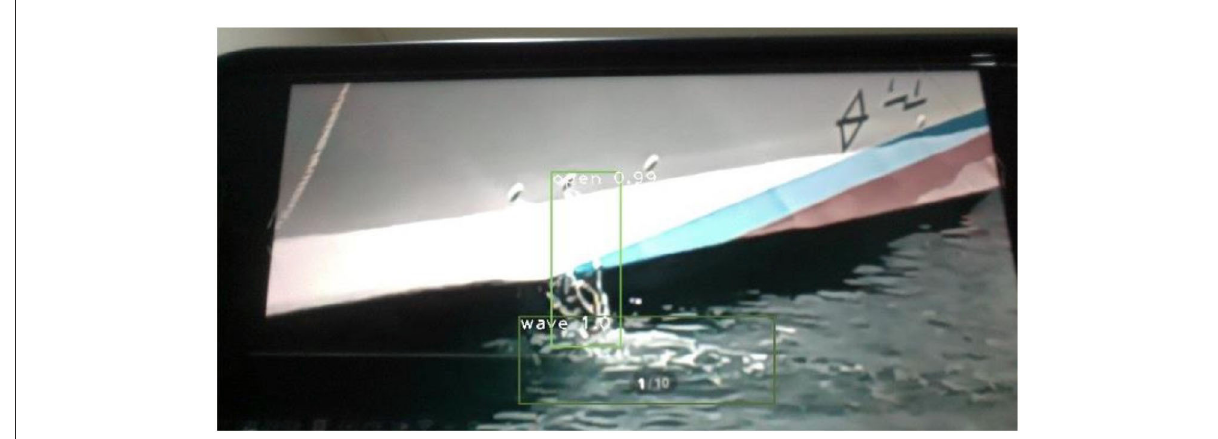
FIGURE3 Monitoring if any sailboat violates the rule to run a motor.